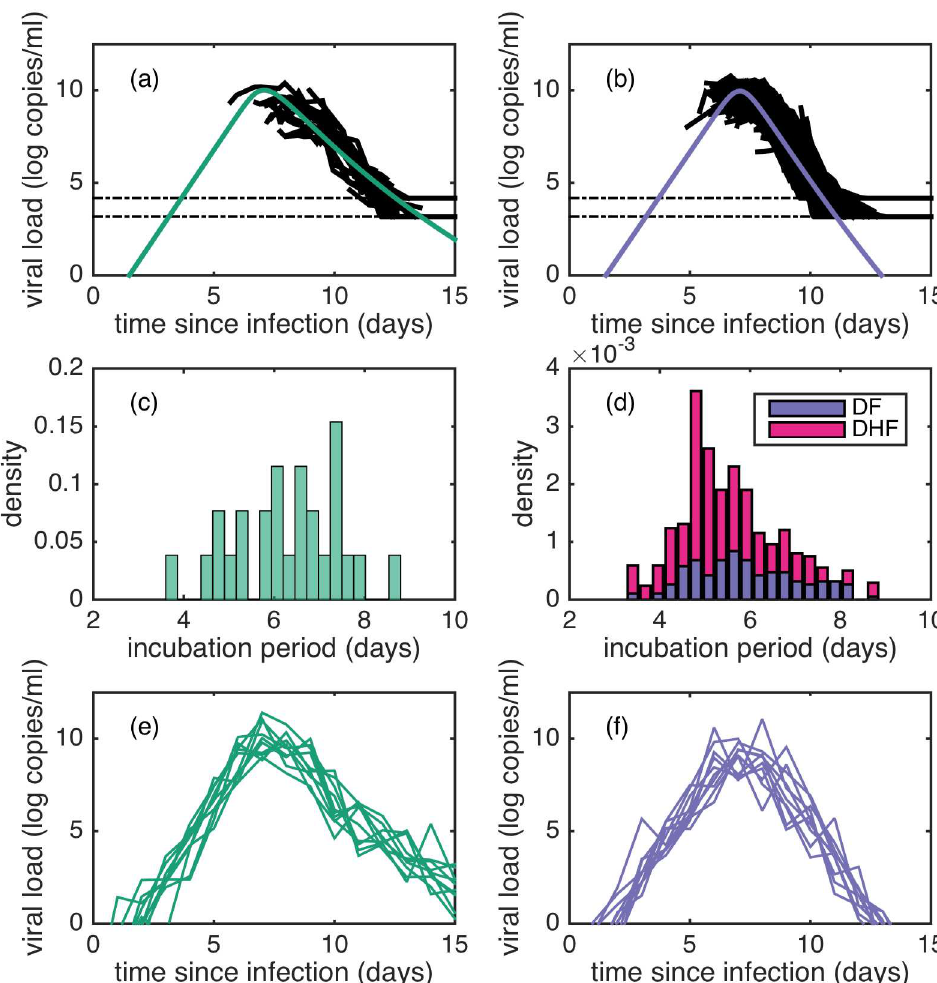
Fig 2. Fits of model 1 to viral load data and forward simulations of model 1. (a) Simulationof model 1 (green) using median log-likelihood estimates, plotted alongsideviral load measurements from all individuals experiencing a primary infection. (b) Simulationof model 1 (purple) using median log-likelihood estimates, plotted alongsideviral load measurements from all individuals experiencing a secondaryinfection. In (a) and (b), viremia measurements are shifted in time based on sampled estimates of individual IP values as describedin Methods. Dotted lines indicate the limits of detection. (c) Histogram showingsampled incubation period estimates for individualsexperiencing a primary infection. (d) Histogram showingsampled incubation period estimates for individualsexperiencing a secondary infection, stratified by clinical manifestation (DF or DHF). (e) 10 forward simulations of model 1 in the presence of observation noise for individualsexperiencing a primary infection. (f) 10 forward simulations of model 1 in the presence of observation noise for individuals experiencing a